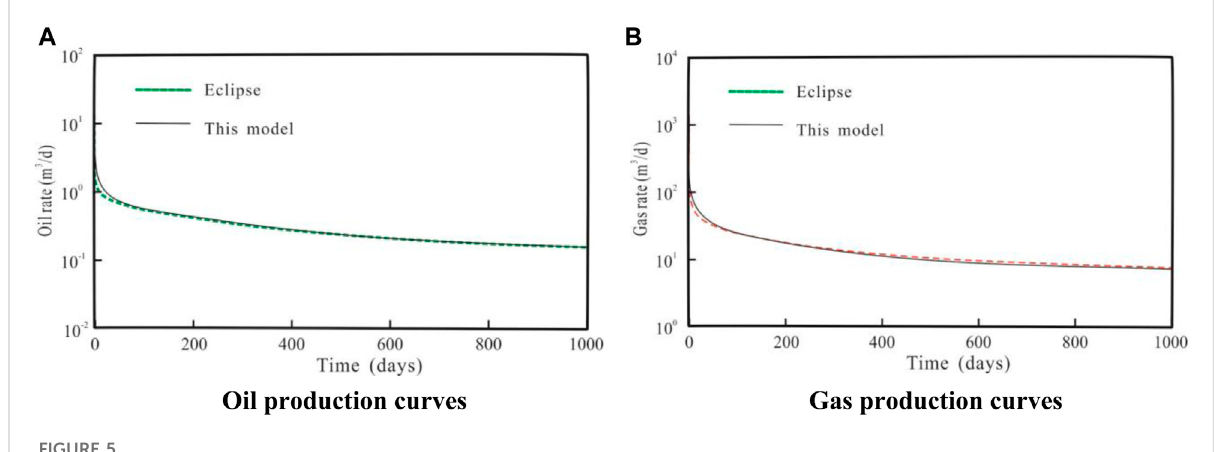
FIGURE 5 Comparison of the proposed model and other methods.